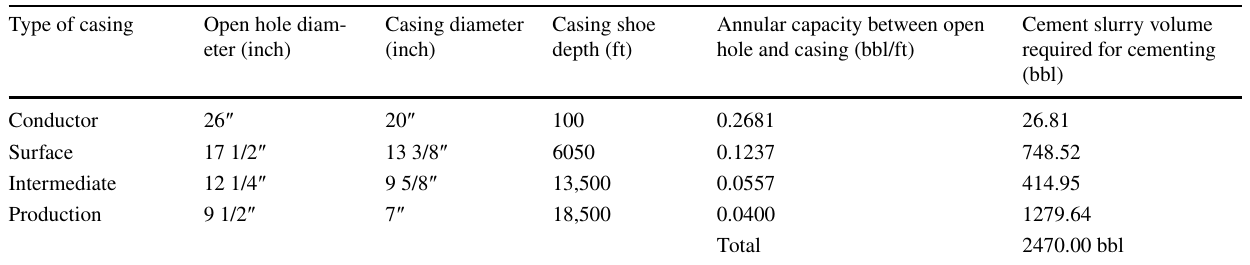
Table 15 Cement slurry volume calculation for the